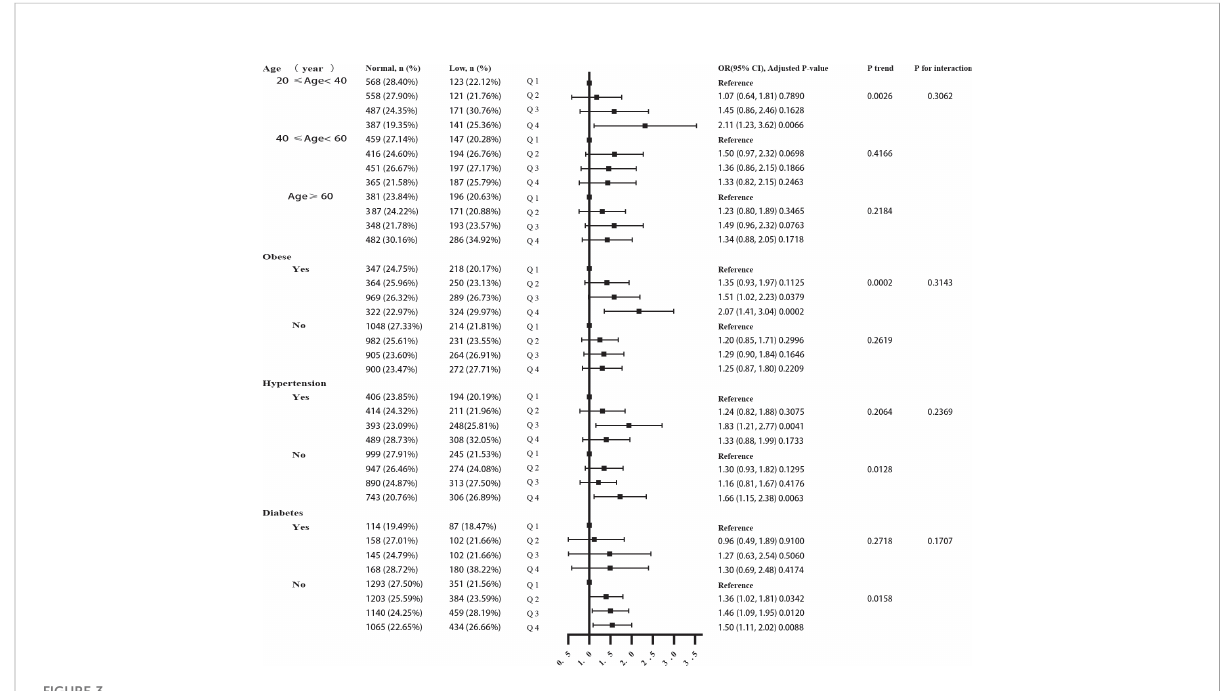
FIGURE 3 The forest plot of correlation subgroup analysis between SII and